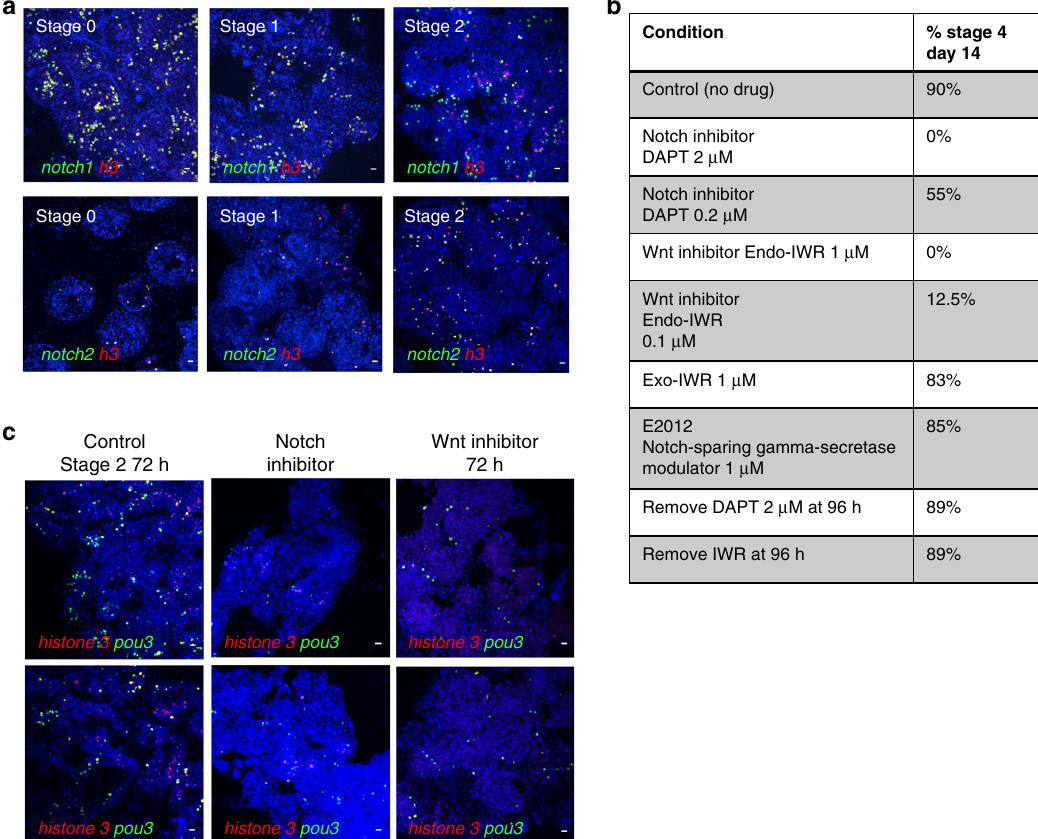
Fig. 6 Inhibition of Notch or Wnt signaling prevents WBR and blocks proliferation of pou3 + cells. a Top panel: FISH for notch1 (green) and h3 (red) during steady state (stage 0) and during early stages of WBR. Bottom panel: FISH for notch2 (green) and h3 (red) during steady state (stage 0) and during early stages of WBR. Images are representatives of four independent experiments. Scale bar 20 μ m. b Table showing the percentages of vessel fragments reaching stage 4 at day 14 post injury during treatment with different doses of inhibitors of canonical wnt signaling (Endo-IWR), Notch-signaling (DAPT) or control drugs Exo-IWR (1 μ M) and the Notch-sparing gamma-secretase modulator E2012 (1 μ M). The number of colonies that reached stage 4 was counted at 14 days post injury. Percentages represent the number of fragments reaching stage 4, with n = 14 – 18 fragments for each condition. Controls (subclones of the same genotype) received vehicle only. c FISH for pou3 (green) and h3 (red) showing a reduction in proliferating pou3 + cells 72 h after surgery when treated with an inhibitor of either Notch or Wnt signaling. Images are representatives of four independent experiments. Scale bars 20 μ